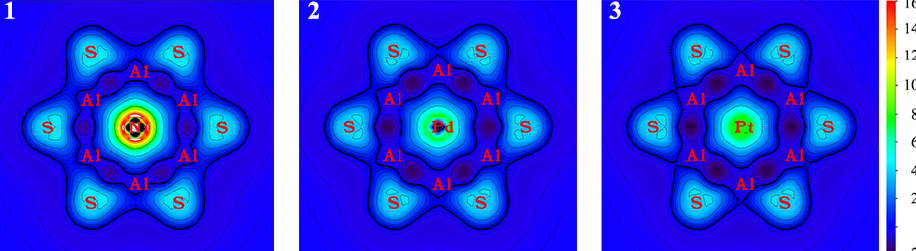
Figure 6. Electron localization function (ELF) of σ electron clouds for 1 – 3 . The approximated bifurcation values are shown.